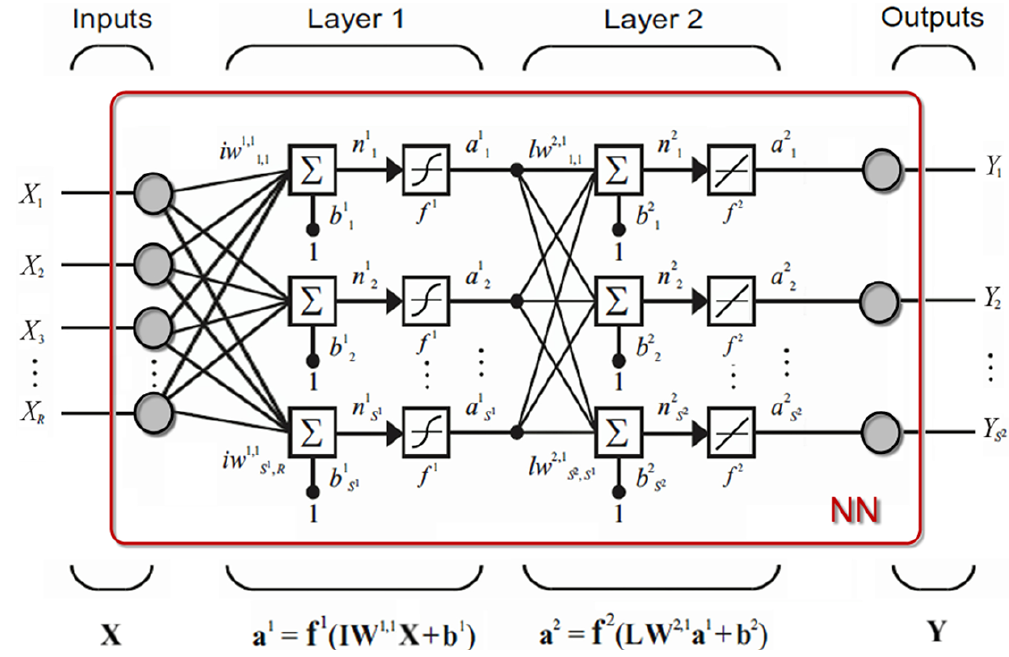
Figure A1. Schematic showing the neural connectivity between input and output parameters in the NILU-UV NN model. The mathematical structure of the neural network model used in this work is described here and is depicted in Fig.